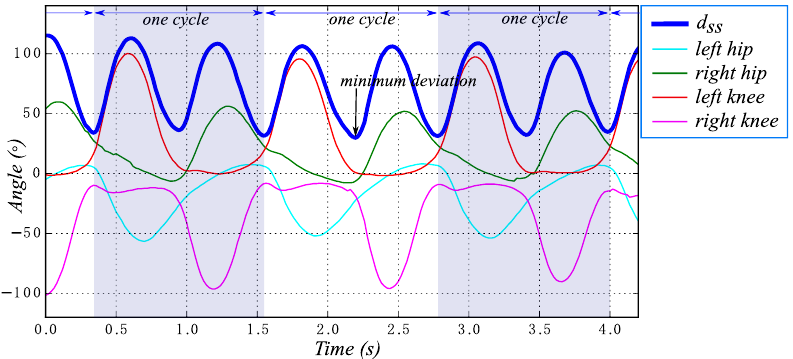
Figure 5. Gait cycle division result with several cycles of one subject walking. The four thin lines below are the original gait. The blue thick line is the deviations curve y pd of the original gait.